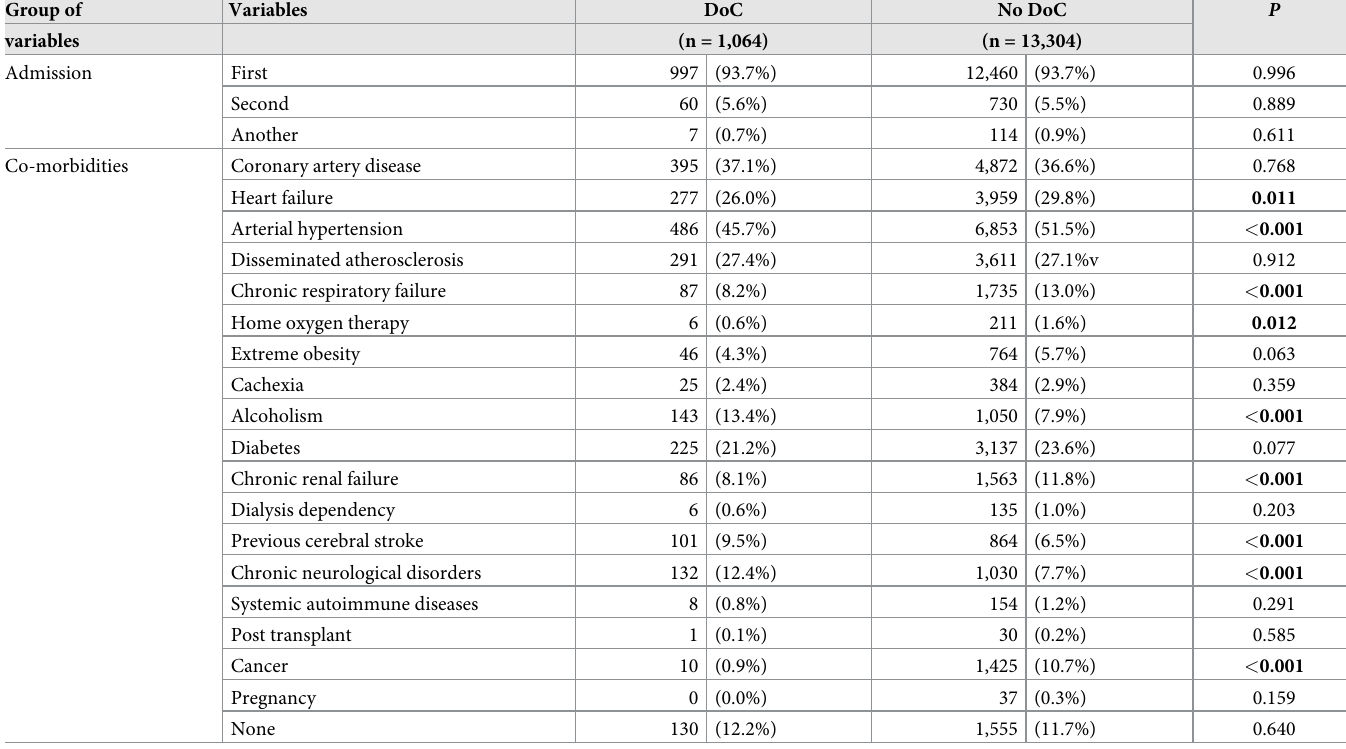
Table 1. Medical status at ICU admission among ICU patients discharged from the ICU with or without DoC. Group